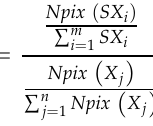
Figure 1. Study area with the fire locations.